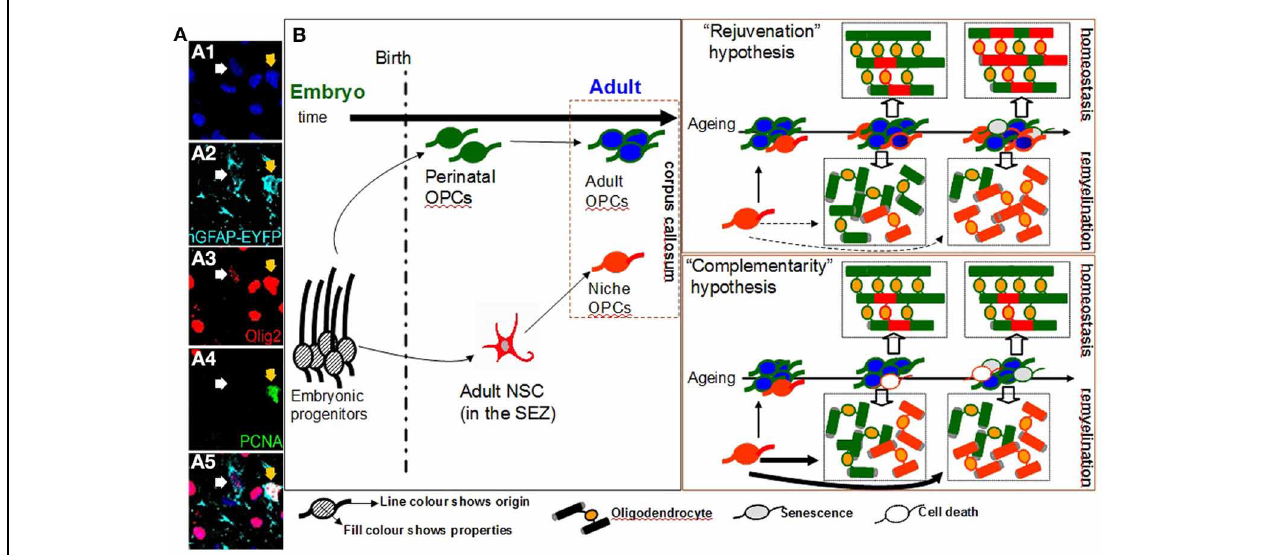
FIGURE 1 | Oligodendrogenesis from niche and parenchymal progenitors in the adult corpus callosum. (Panel A ) Numerous cells of the oligodendroglial lineage (both OPCs and oligodendrocytes, here all identified by expression of Olig2, in red) populate the adult corpus callosum (cc). A fraction of these is generated within the adjacent SEZ cytogenic niche (here identified by the expression of EYFP, in cyan, with two examples shown with arrows). OPCs are a mitotically active cell population as indicated by the expression of the mitotic marker PCNA (in green; note that the yellow arrow shows a proliferating OPC of SEZ origin). (Panel B : Diagram) A schematic illustration of the possible role of niche-derived OPCs in oligodendrogenesis in the adult cc. One fraction of OPCs in the cc is derived from perinatal OPCs (cells of green outline) that have switched to an adult, self-renewing mode of division (cells of blue fill); whilst, another is derived from adult neural stem cells located in the SEZ (cells of red outline). According to the “rejuvenation hypothesis”, niche OPCs migrate in the cc and gradually acquire properties similar to those of parenchymal adult OPCs (such as self-renewing potential). According to this scenario the main role of niche OPCs is to provide freshly-born